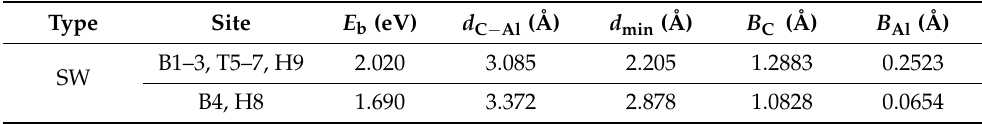
Table 2. The key parameters of the SW defect graphene/Al (111) interface after